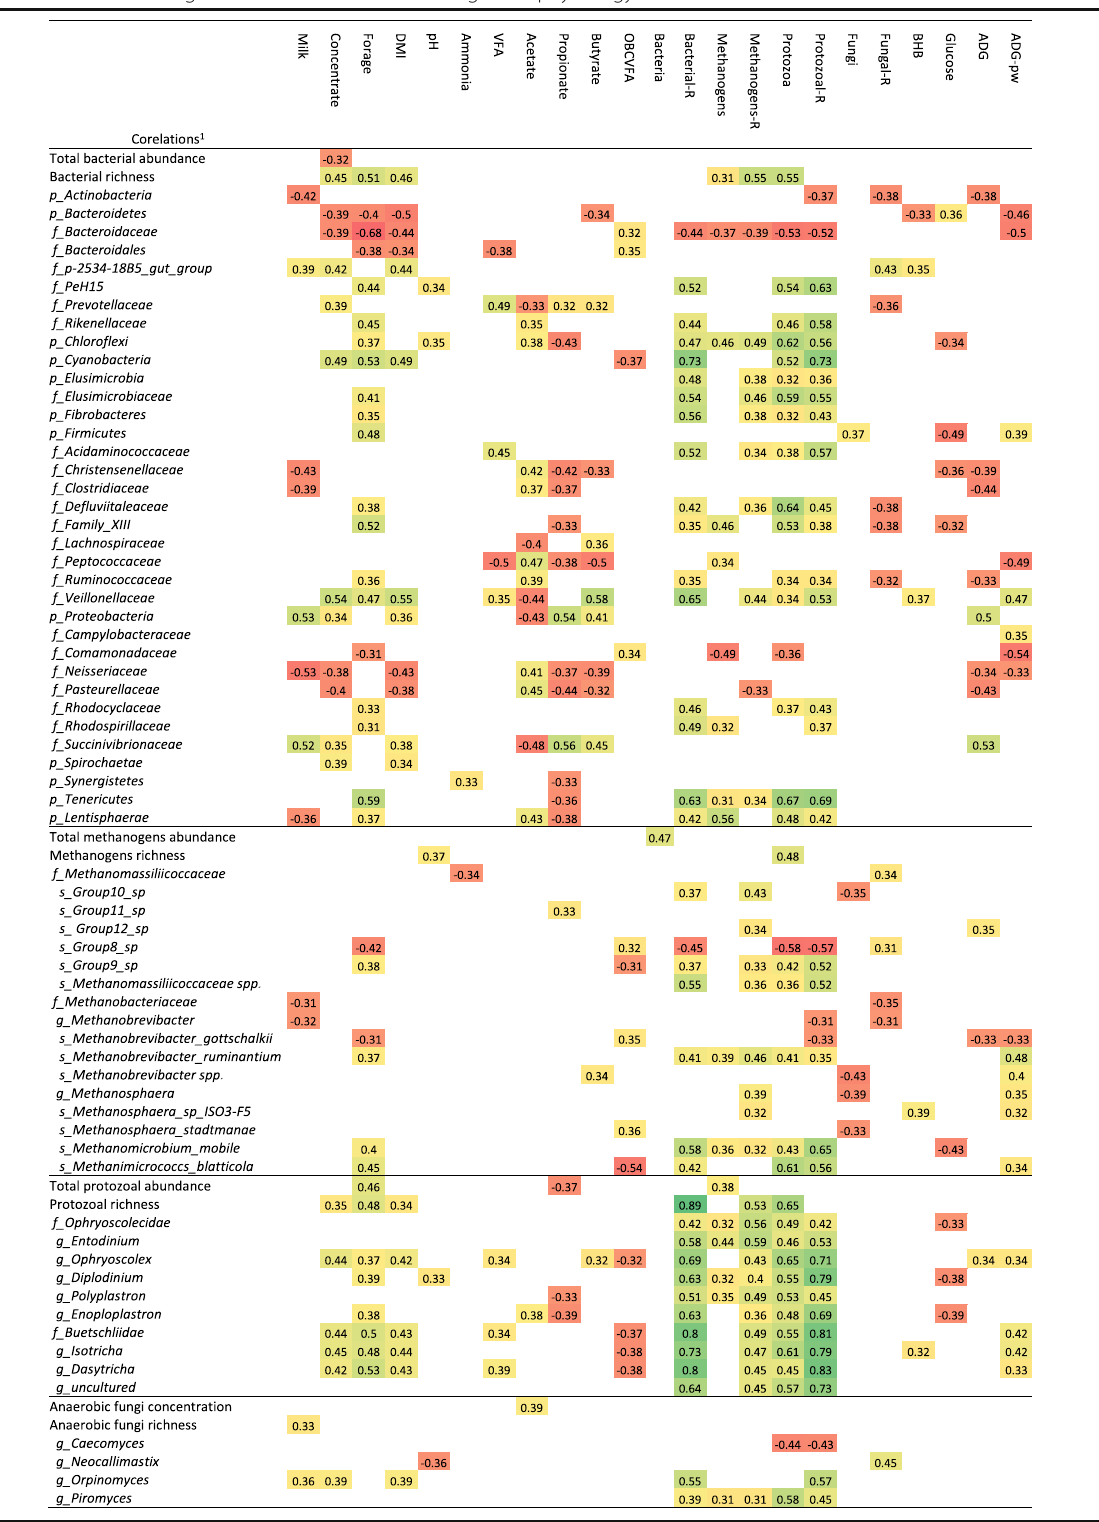
Table 2 Correlations among the rumen microbiota and digestive physiology